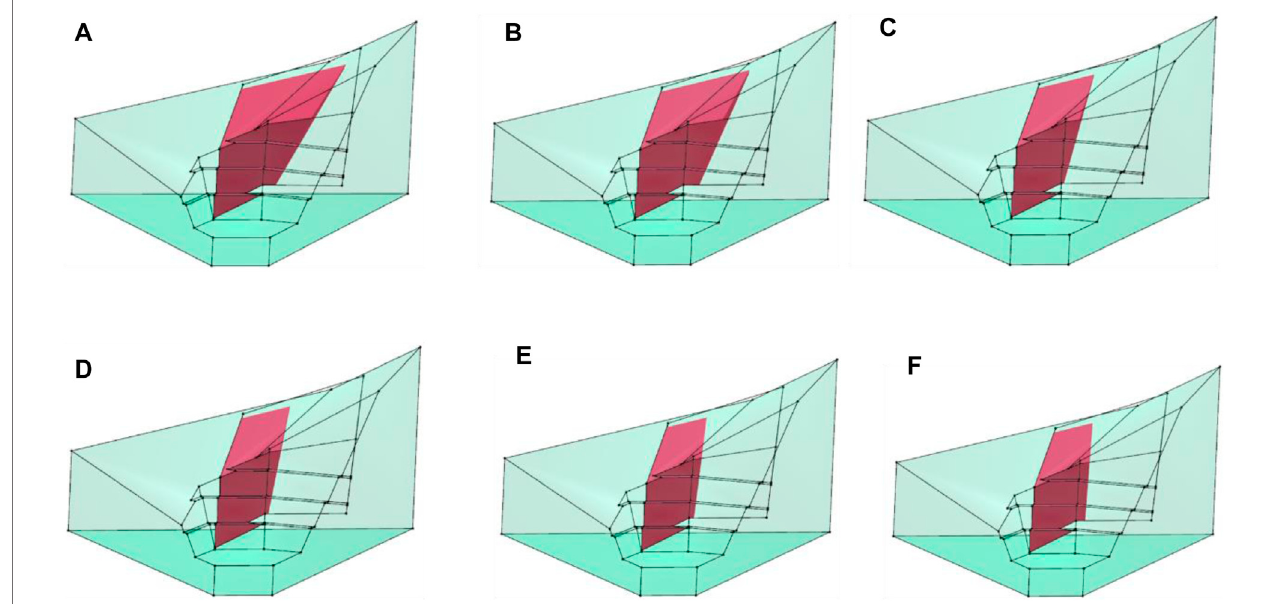
FIGURE 10 | Shapes of blocks with different shear surface